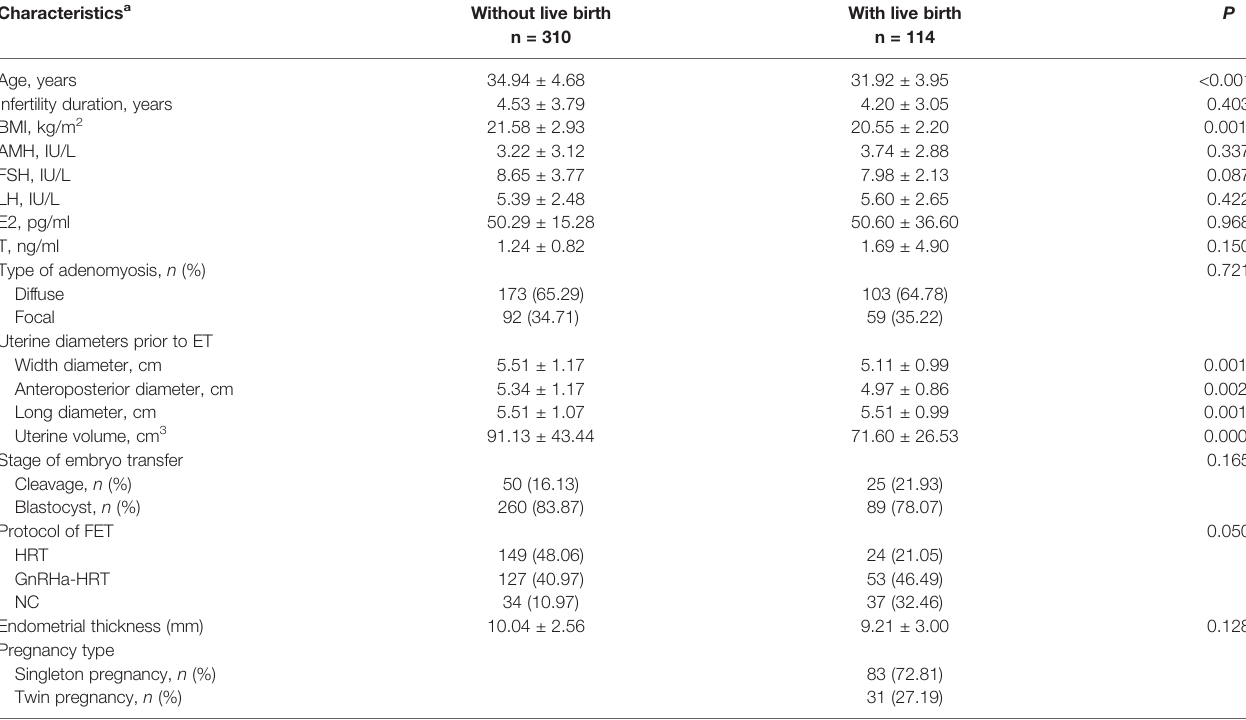
TABLE 1 | Characteristics of the patients with and without live birth. Characteristics a Without live